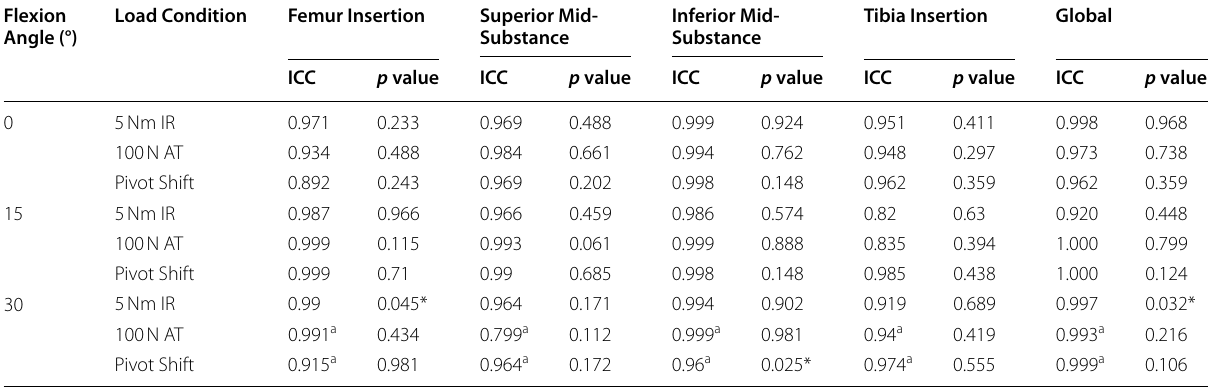
IR Internal Rotation, AT Anterior Translation Force